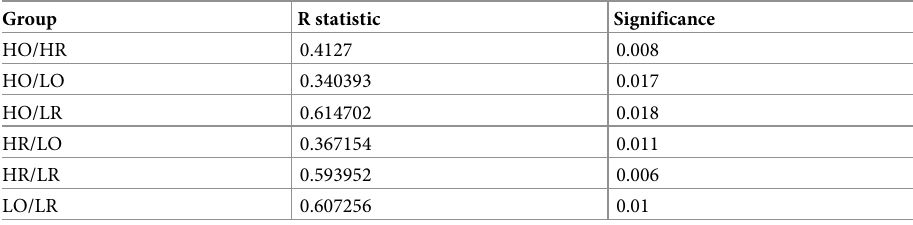
Table 5. PERMANOVA pairwise comparisons of bacterial community